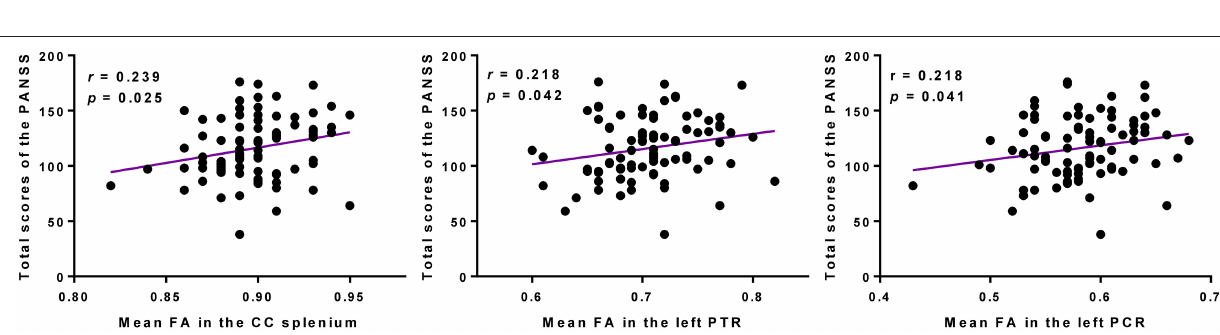
FIGURE 4 | Higher FAs in the CC splenium, left PTR, and left PCR were correlated with more severe psychopathology symptoms in participants with schizophrenia. PANSS, Positive and Negative Syndrome Scale; FA, fractional anisotropy; CC, corpus callosum; PTR, posterior thalamic radiation; PCR, posterior corona